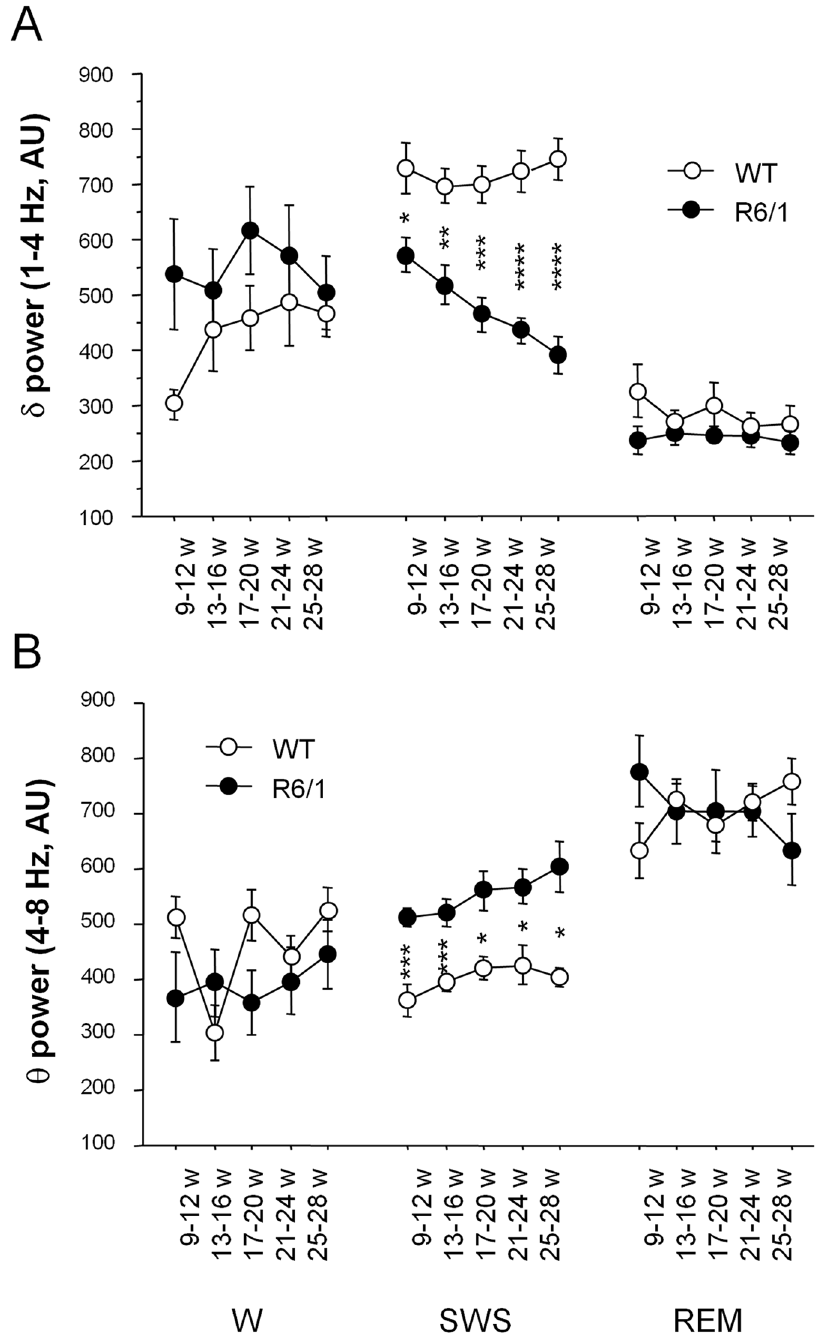
Fig 3. Spectral analysis of recordings during waking (W), slow wave sleep (SWS) and REM sleep (REM) in both genotypes across 5 ages. Averaged summed delta (1-4Hz) (A), theta power (4 – 8 Hz) (B) at different ages in both genotypes. * R6/1 mice significantly different from age-matched WT littermates at p < .05, ** at p < .01, *** at p < .001, **** at p < .0001, AU: Arbitrary unit.